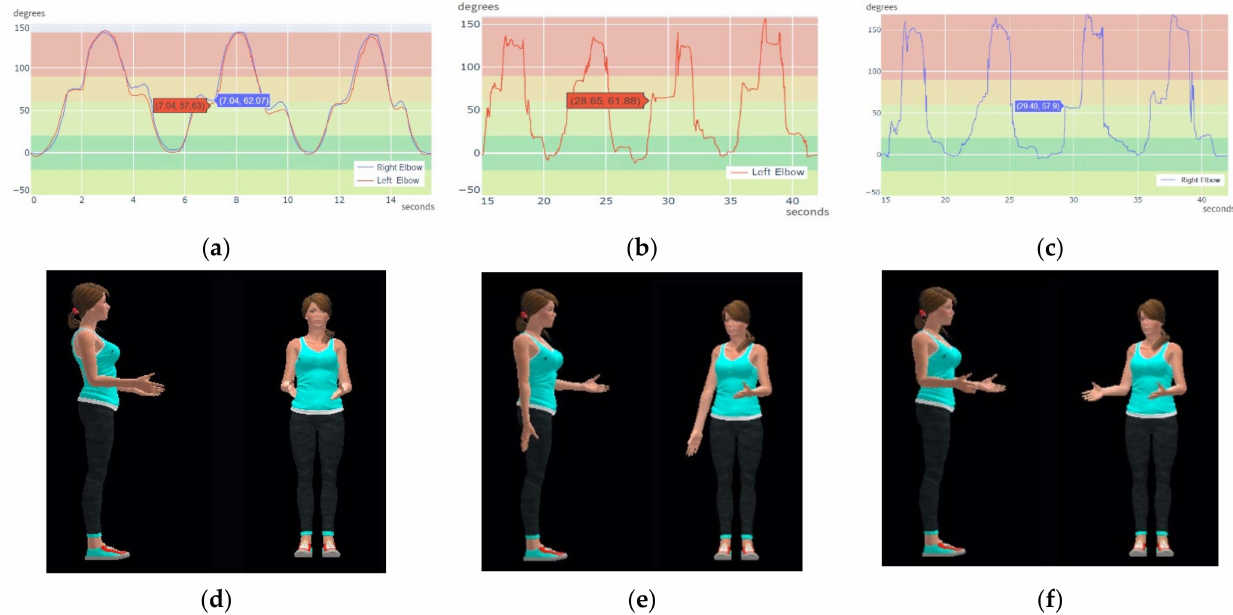
Figure 17. Detail of computed angle plot in a crowded environment for elbow exercise: ( a ) Left and right elbow flexion using CW sensors data; ( b ) Left elbow flexion using XDOT data; ( c ) Right elbow flexion using XDOT data. Movement reconstruction in 3D: ( d ) CW sensors; ( e ) XDOT sensors at 28.5 s; ( f ) XDOT sensors at 29.5